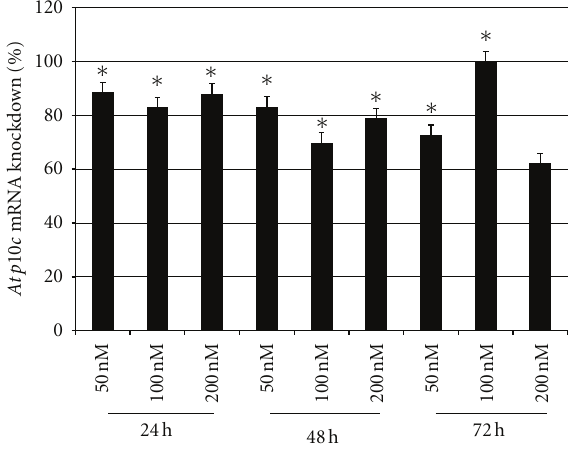
Figure 1: C2C12 cells were di ff erentiated from myoblasts to myotubes as described in Section 2. Myotubes were transfected at each concentration of siRNA (SI00906220) (0, 50, 100, and 200 nM) collected at the above time points (24, 48, and 72 h). Gapdh (housekeeping gene) and Atp10c gene mRNA expression was analyzed using quantitative PCR. The percentage of knockdown was calculated at each concentration and time point based on the expression of the mock-transfected (0nM) samples ( ∗ P < 0 . 7 based on Qiagen recommendations). Data represents three independent experiments with each sample repeated in